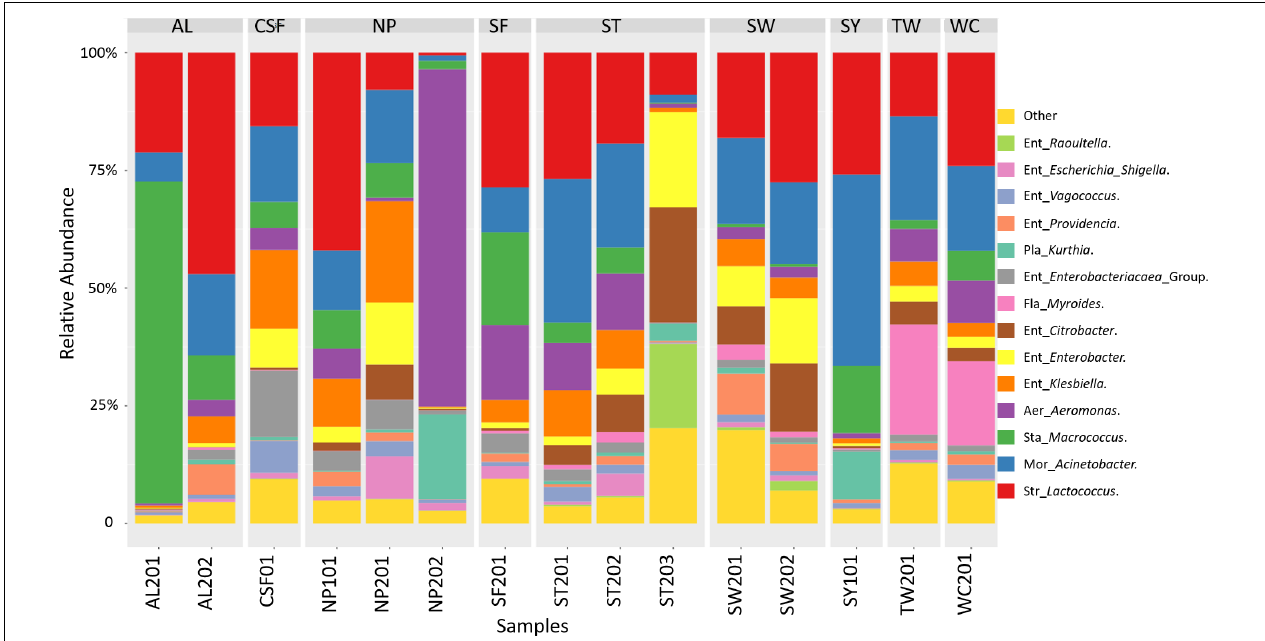
FIGURE 2 | Taxonomic community profiles at the genus level following 16S metagenomic sequencing performed on swab samples collected at nine wet markets in Hong Kong Island, and analyzed using Parallel-Meta.